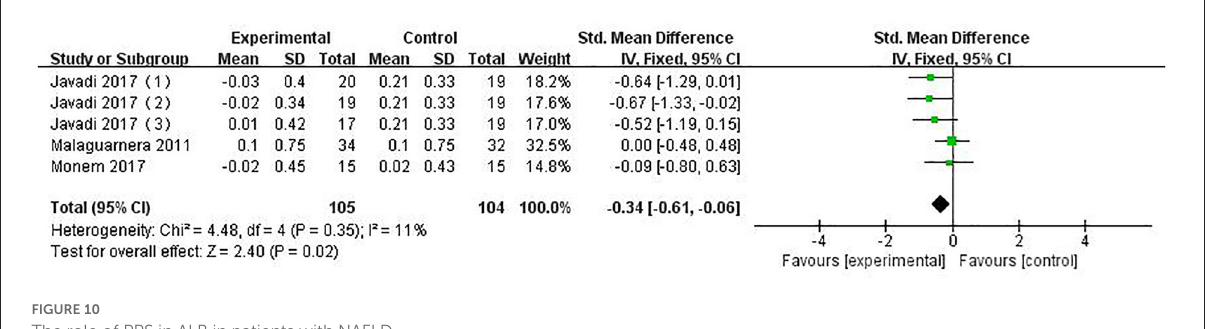
FIGURE10 The role of PPS in ALB in patients with